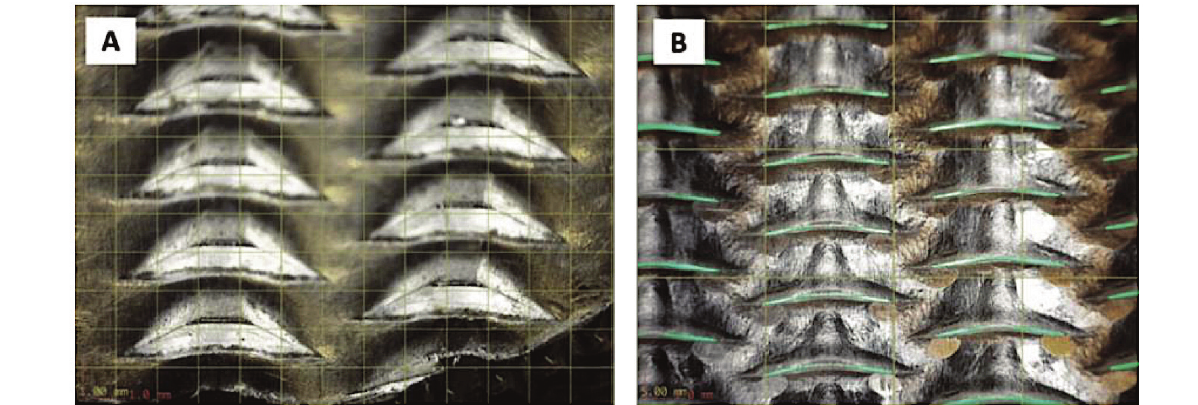
Fig. 2. Microscopy images revealing the aperture shape and size of materials A (left) and B (right).